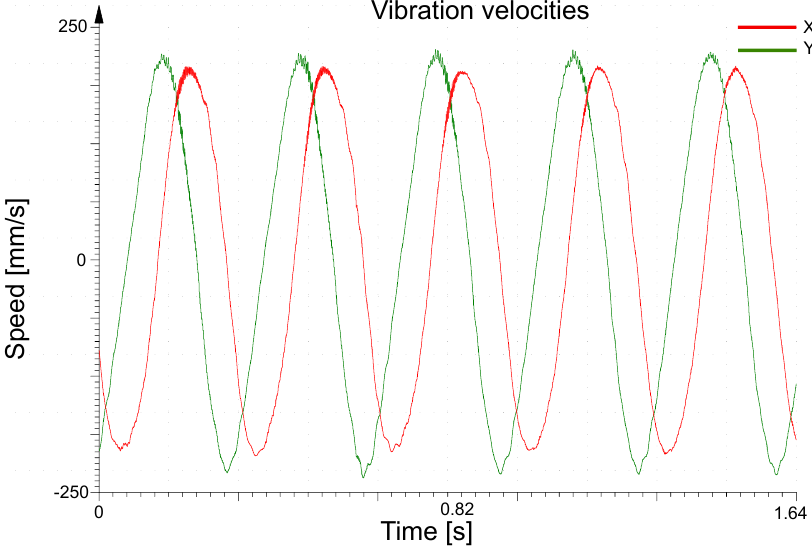
Figure 14. Speeds on x (red) and y (green) axis. As the two curves are delayed by π affected by